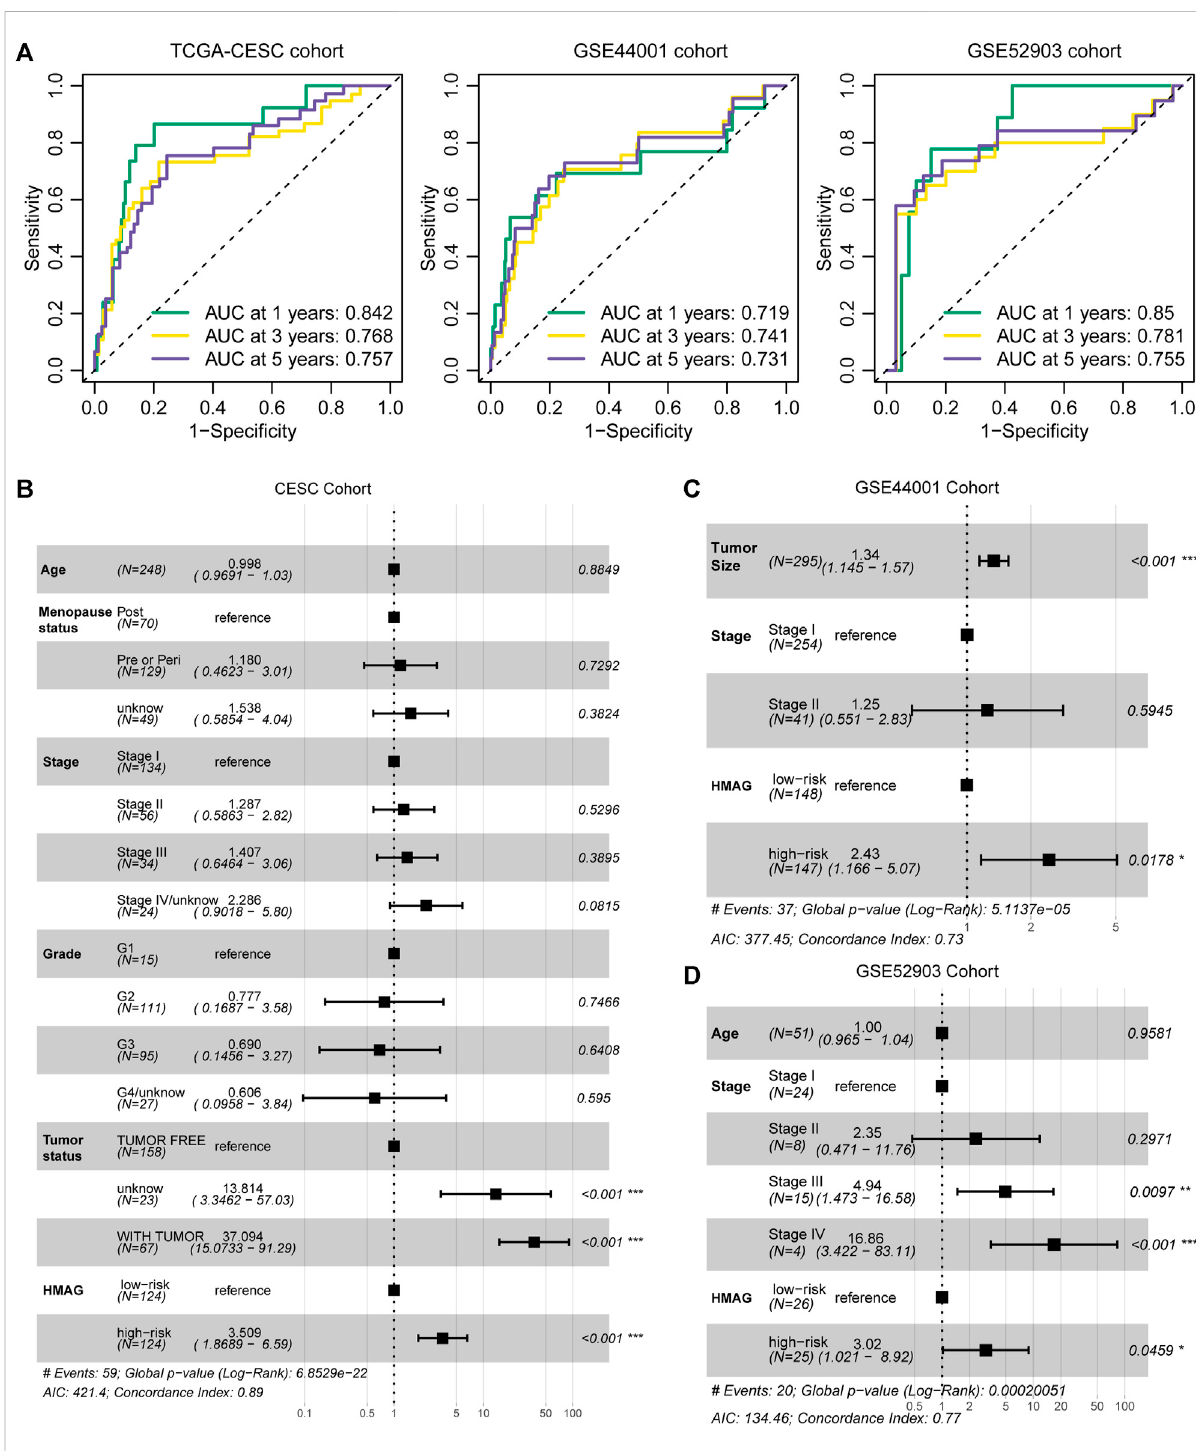
FIGURE 4 Evaluation of the prognostic value of the HMAG signature. (A) 1-year, 3-year, and 5-year AUC values in TCGA-CESC, GSE44001, and GSE52903cohorts; (B) forestplotshowingtheprognosticvalueoftheHMAGsignatureafteradjustingforclinicalfeaturesinTCGA-CESCcohort; (C) forest plot showing the prognostic value of the HMAG signature after adjusting for clinical features in the GSE44001 cohort; and (D) forest plot showing the prognostic value of the HMAG signature after adjusting for clinical features in the GSE52903 cohort.